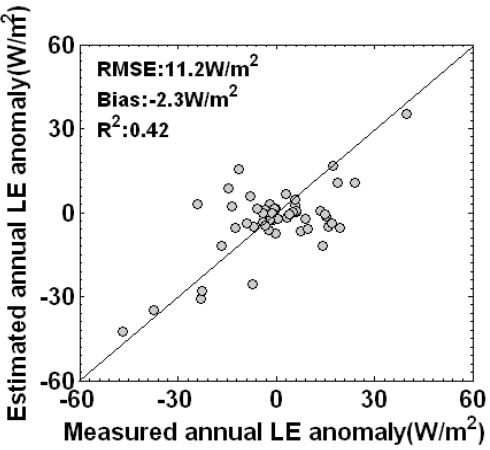
Figure 5. Comparison of the annual anomalies of predicted LE and ground-measured LE collected at the flux towers sites where at least five years of data are